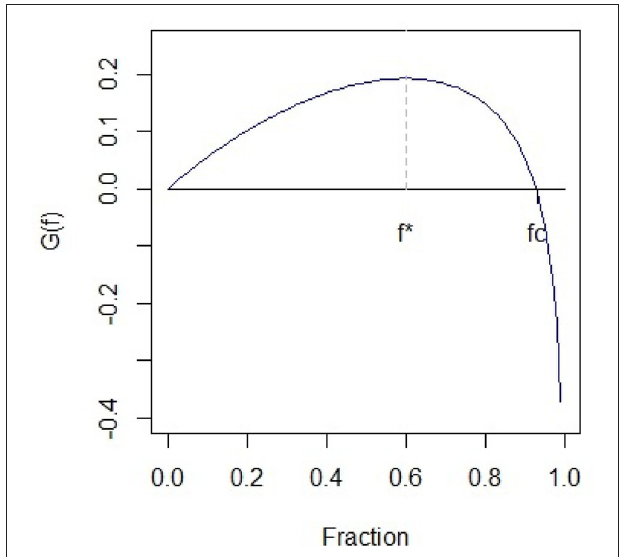
FIGURE 1 | Growth rate function G ( f ) for different proportions of wealth ( f